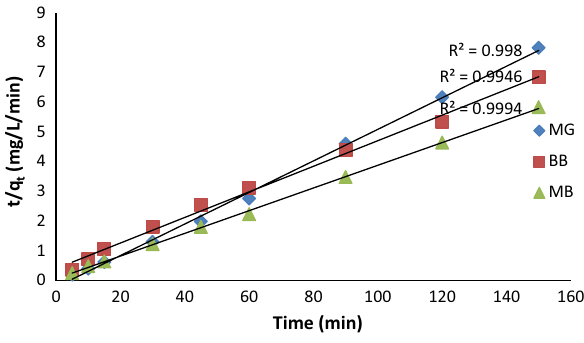
Fig. 10 Pseudo-second-order graph for adsorption of